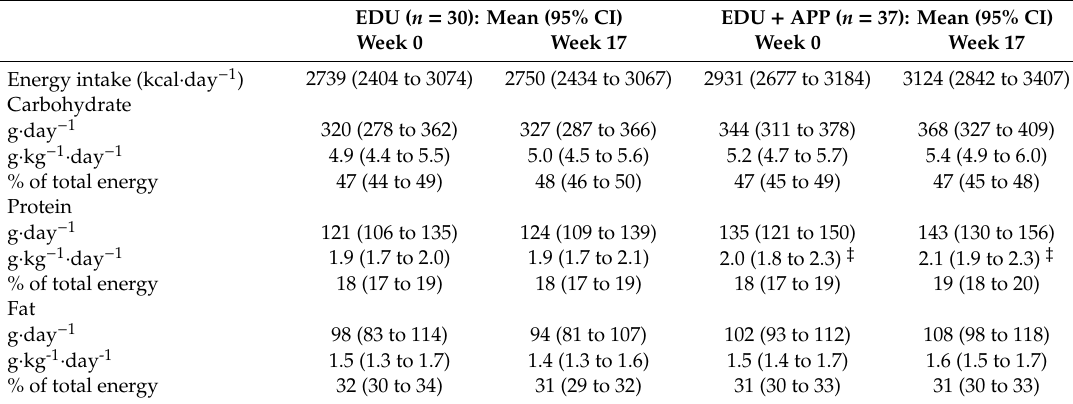
Table 3. Energy and macronutrient intakes (95% confidence interval in parenthesis) of